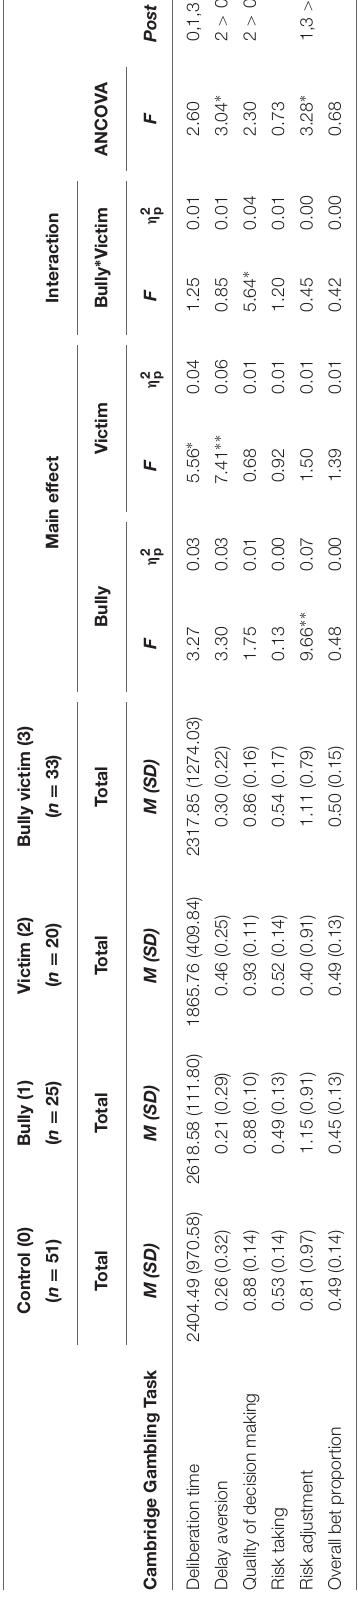
TABLE 5 | Hierarchical regressions predicting cognitive appraisal in risky events variables among bully total.